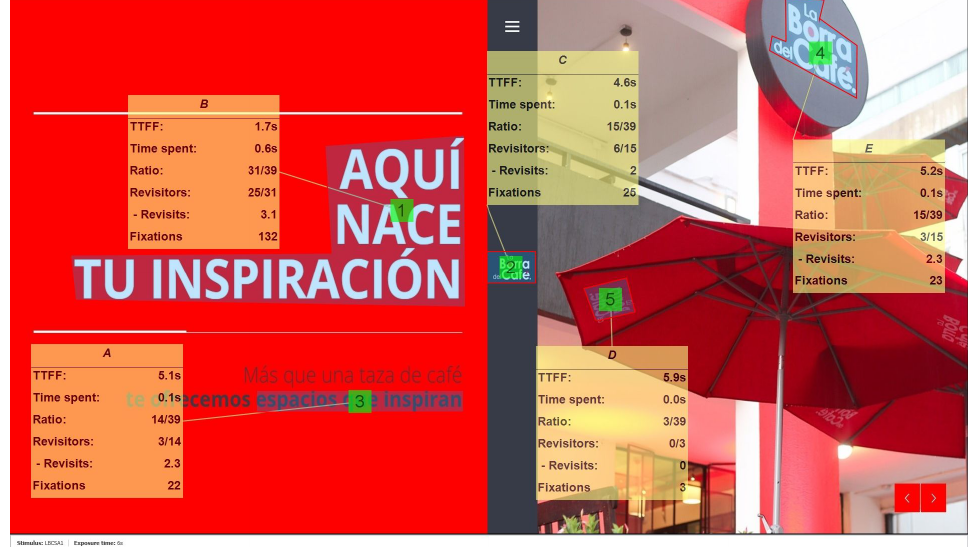
Figure 2. Old website design—denoted as static website design and off-stimulus—with 5 areas of interest (AOI) metrics. Note: time to first fixation (TTFF). (1) brand slogan in white font; (2) brand name in white font; (3) brand advertising phrase in black font; (4) brand name in white font in company sign; (5) brand name in white font in company umbrella. Note: Table A3 contains the same metrics for a more readable